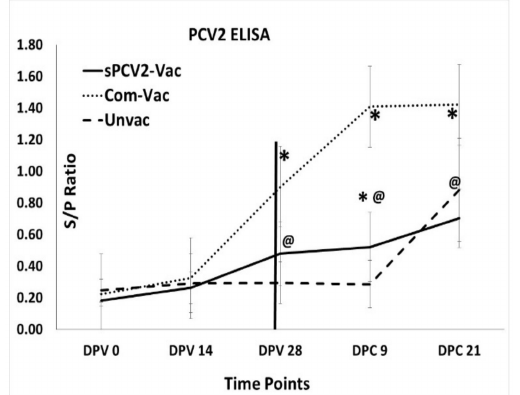
Figure 4. Anti-PCV2 IgG responses. Mean binding antibody responses to PCV2 as measured by a PCV2-specific commercial ELISA kit. X -axis—time points at which serum was collected, DPV— days post-vaccination, DPC—days post-challenge. Error bars represent the standard deviation. Y -axis—signal to positive (S/P) ratio, dots—commercial vaccine, solid black—sPCV2-Vac, dashes— unvaccinated pigs. * Significantly different from the unvaccinated control group by the Student’s t -test at p ≤ 0.05, @ significantly different from the commercial vaccine control group by the Student’s t -test at p ≤ 0.05.